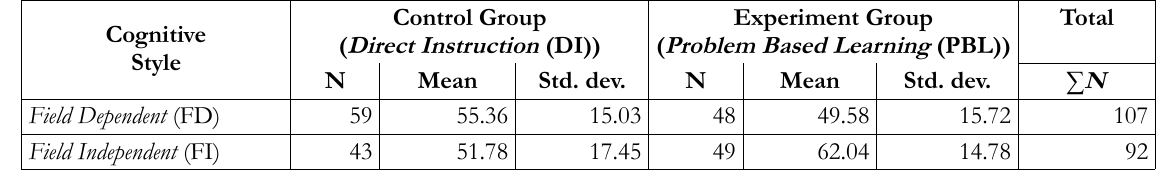
Table 5. Identification of Students Cognitive Styles and The Initial Test of Critical Thinking Skill